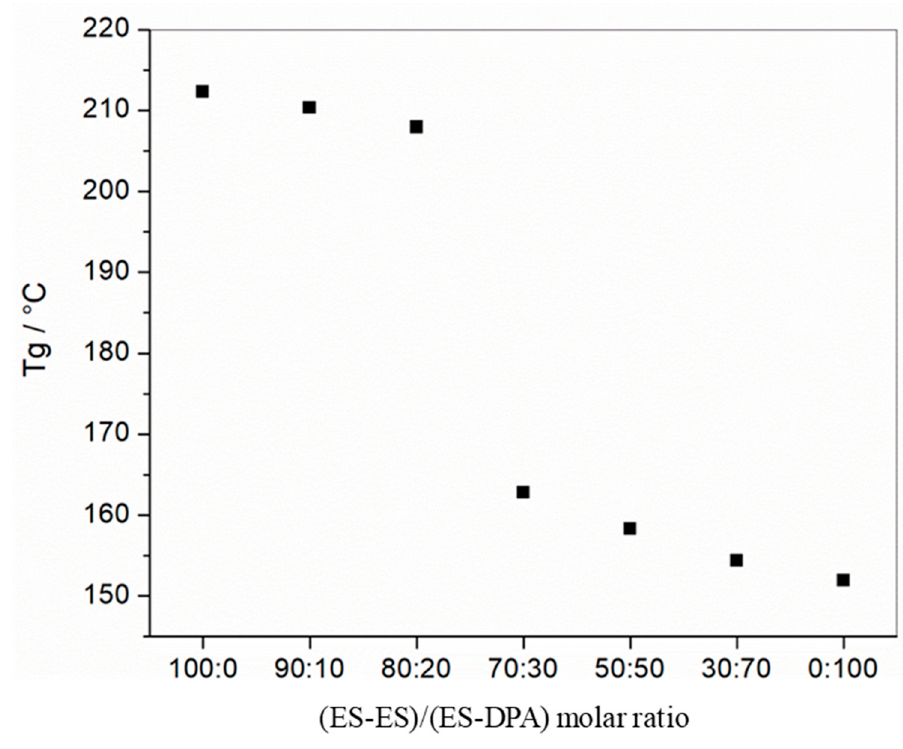
Figure 9. Glass transition temperature (Tg) of the copolymers versus the (ESES)/(ESDPA) molar ratio.